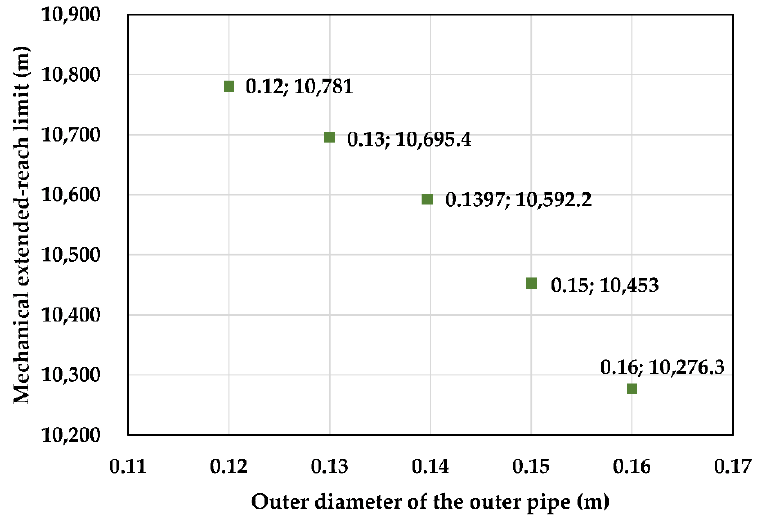
Figure 9. Effect of the outer diameter of the outer pipe on the mechanical extended-reach limit.